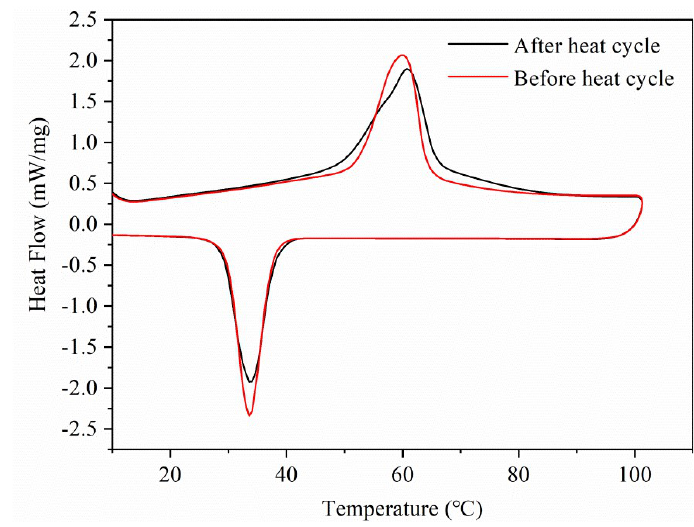
Figure 10. DSC curves of CPCM3 before and after the heat cycle.